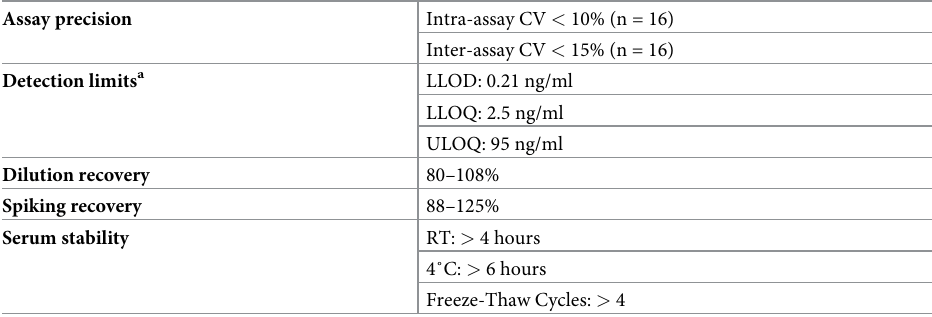
Table 1. Summary of Col3-4 ELISA analytical performances.